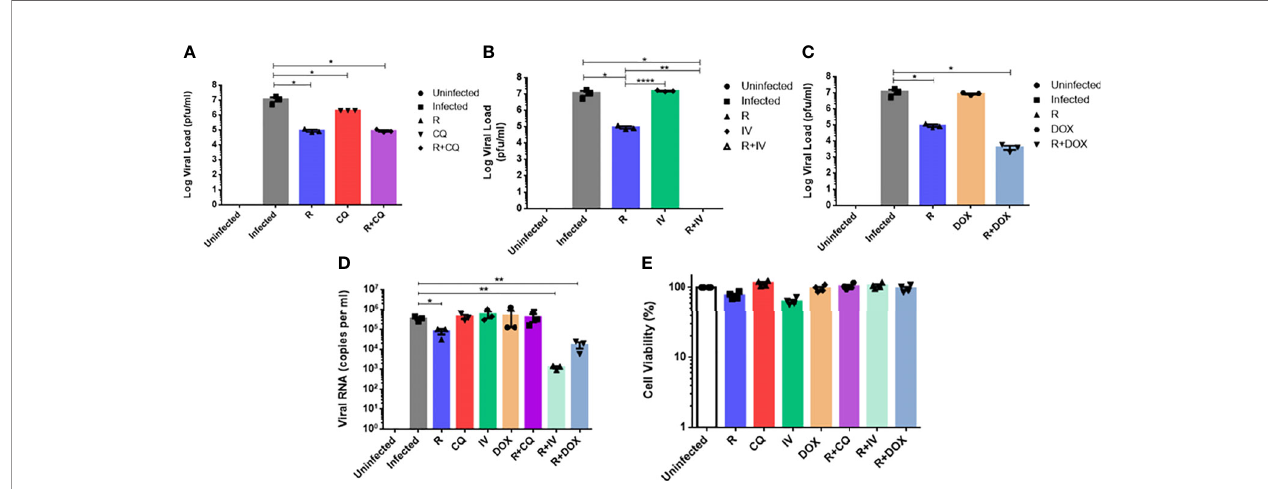
FIGURE 2 | Comparison of antiviral activities of monotherapy versus combination therapy using remdesivir with chloroquine, ivermectin and doxycycline against MHV infection of RAW264.7 macrophages. Remdesivir (R) was tested at a concentration of 6 µM alone or in combination with the other three drugs. Uninfected cells, and infected but untreated cells served as controls. Live coronavirus titers were quanti fi ed using plaque assays. (A) Infected cells were treated with 15 µM of chloroquine (CQ) alone or combined with R. (B) Infected cells were treated with 2 µM of ivermectin (IV) alone or combined with R. (C) Infected cells were treated with 15 µM of doxycycline (DOX) alone or combined with R. (D) Quanti fi cation of MHV RNA loads (copies per ml) in extracts of supernatants from the above experiments using real-time RT-qPCR. Error bars represent SEM. Statistical signi fi cance was determined by one-way ANOVA with Dunnett ’ s multiple comparison, and P -values denoted by asterisks: * P < 0.05; ** P < 0.01; **** P < 0.0001. (E) Cell viability pro fi les of uninfected and drug-treated cells at tested concentrations. Mean percentages of cell viability were normalized to untreated cells and blank controls. Experiments were carried out in